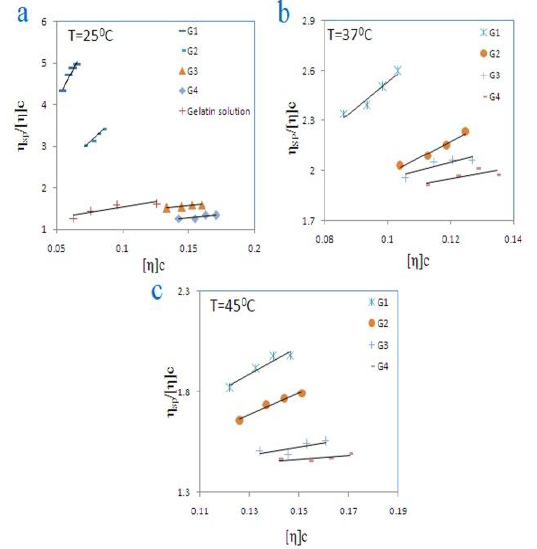
3a demonstrates the Huggins function, H=η /c[η ] as a function of reduced concentration, sp [η]c, all nanoparticles and a normal gelatin solution prepared at its native pH=5.4 and T=25 0 C. The intrinsic viscosity for G1, G2, G3 and G4 was found to be 15.6, 20.3, 38.1 and 40.7 ml/g respectively, and 25.2 ml/g for gelatin solution at pH =5.4.